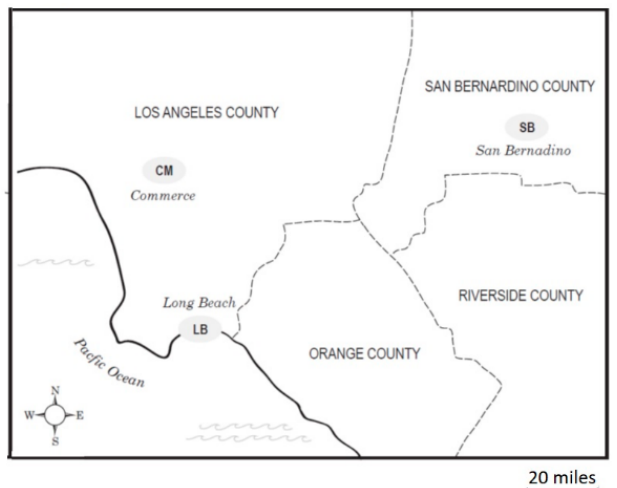
Figure 1. Map of the Los Angeles Basin with locations of the air collection sites: Long Beach (LB), Commerce (CM) and San Bernardino (SB). The Los Angeles Basin contains a coastal area bordered by the San Gabriel Mountains located in northern Los Angeles County and western San Bernardino County.